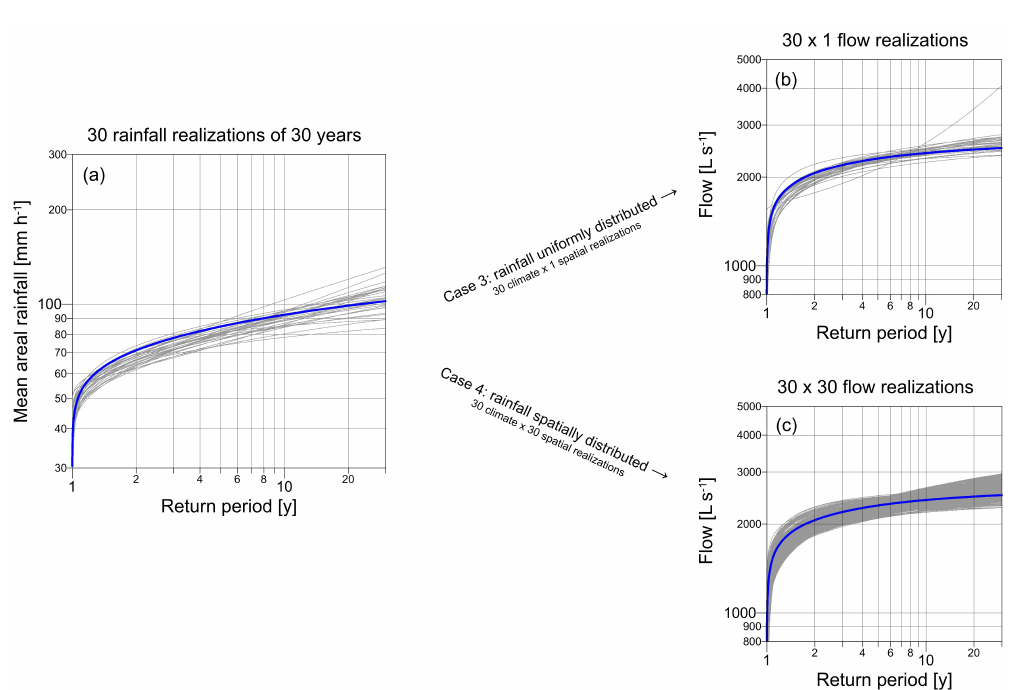
Figure 9. Same as Fig. 6, but for location C and cases 3 and 4. The poorly fitted GEV distribution for one realization presented in (b) was excluded from the flow variability partitioning